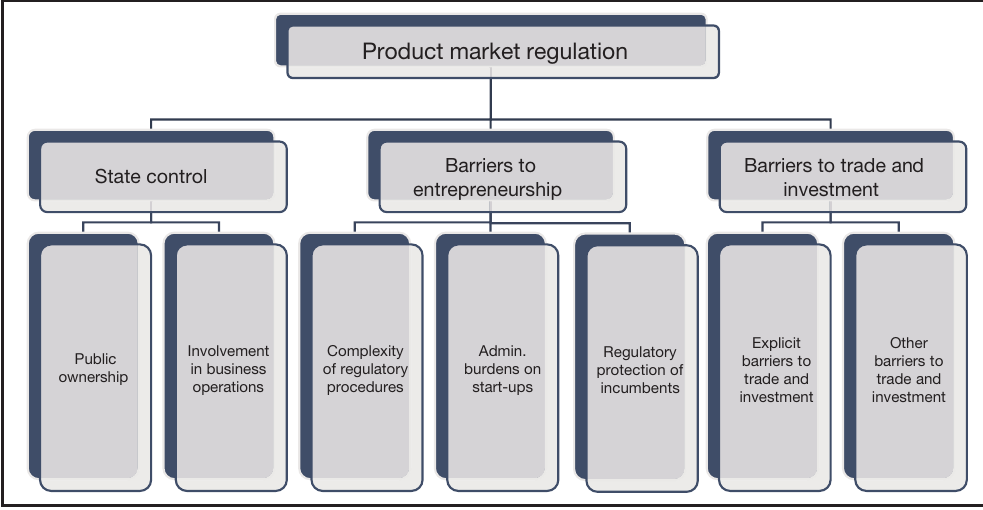
Figure 3 EPL indicator – OECD definition.